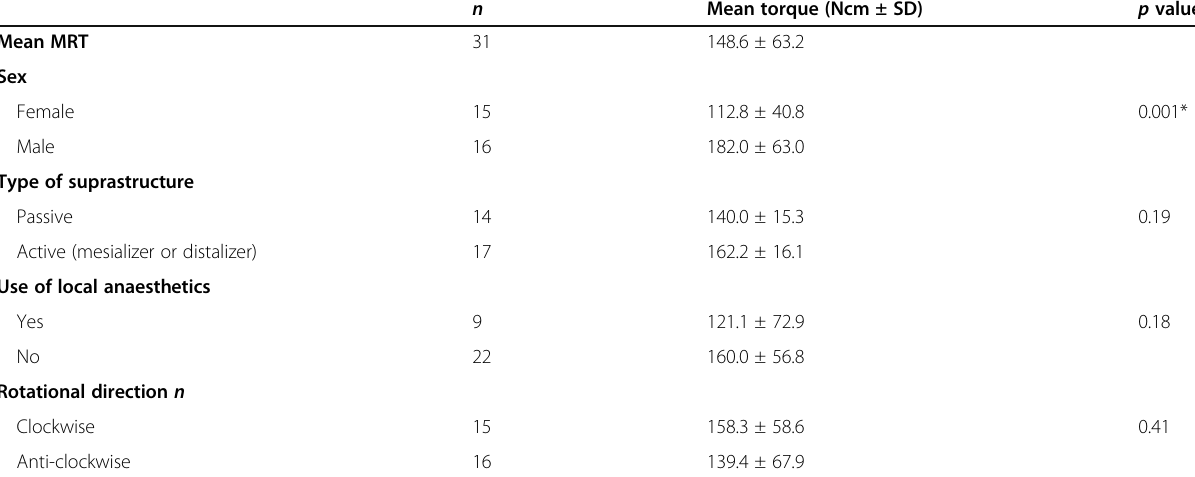
Table 2 T -test results for comparison of the various palatal implant variables